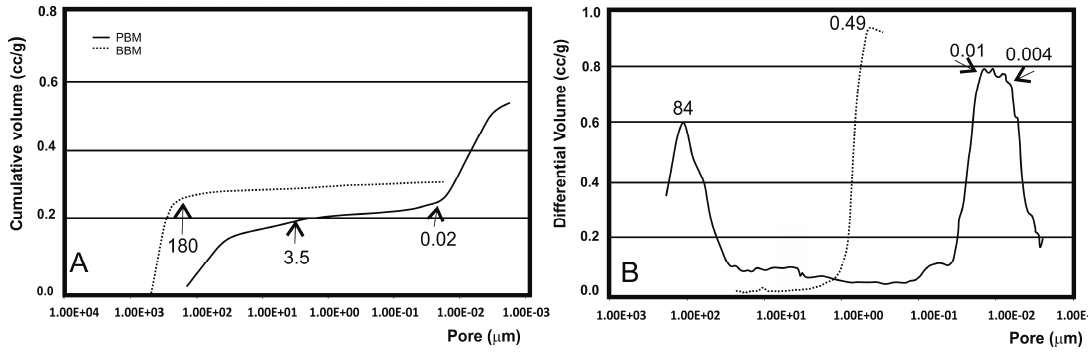
Figure 4. Mercury intrusion curves of the PBM and BBM ceramics measured by mercury porosimetry: ( A ) cumulative intruded volume versus pore diameter; and ( B ) differential-intruded volume versus pore diameter.